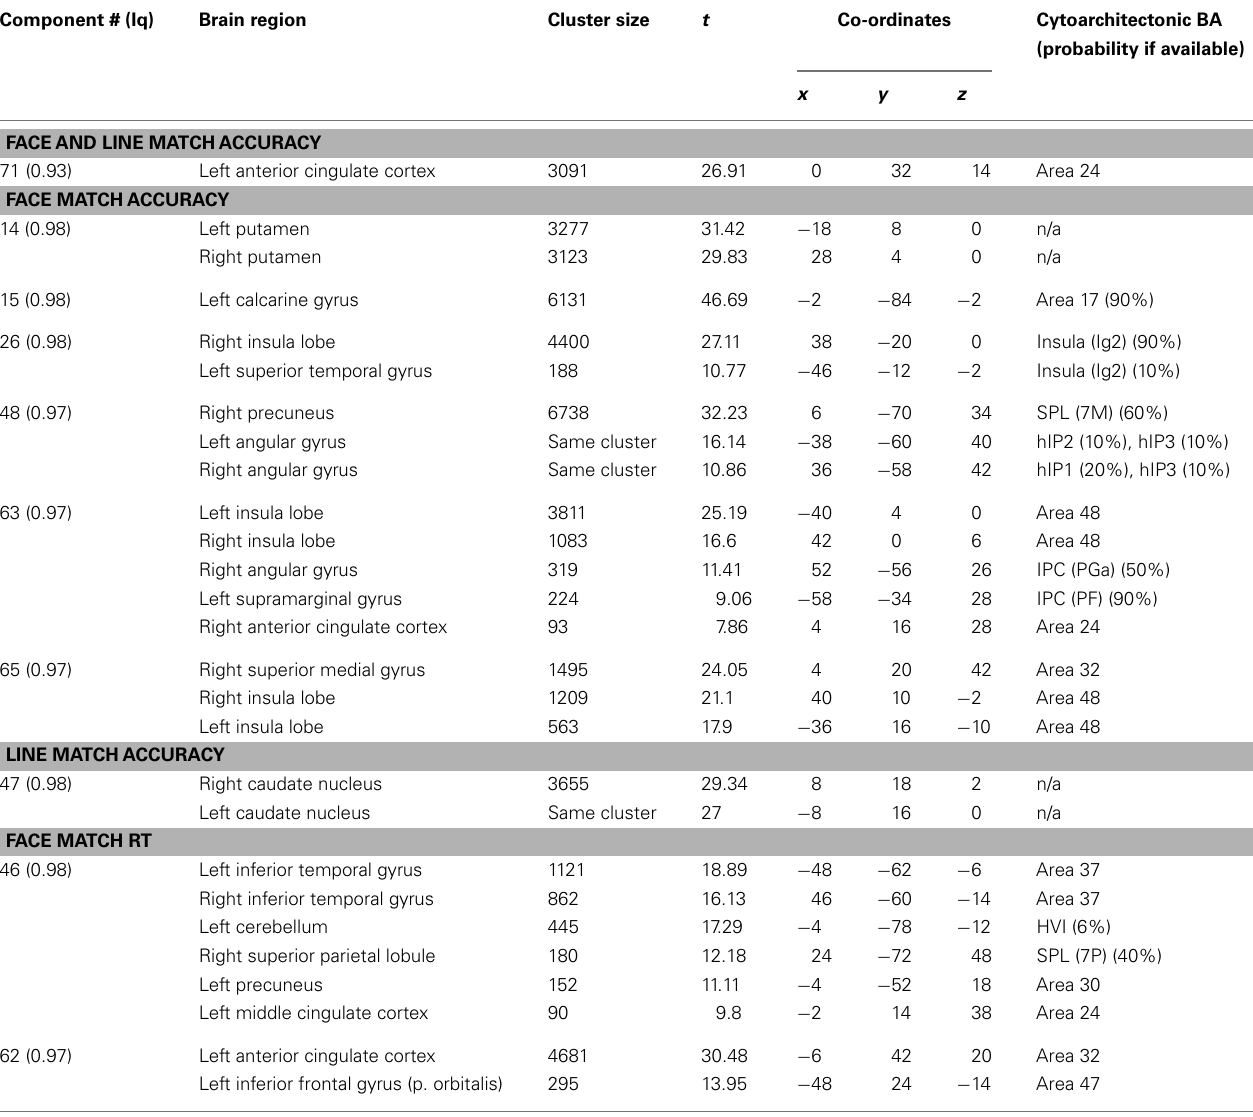
Table 1 | Peak activations of spatial maps showing a relationship with task